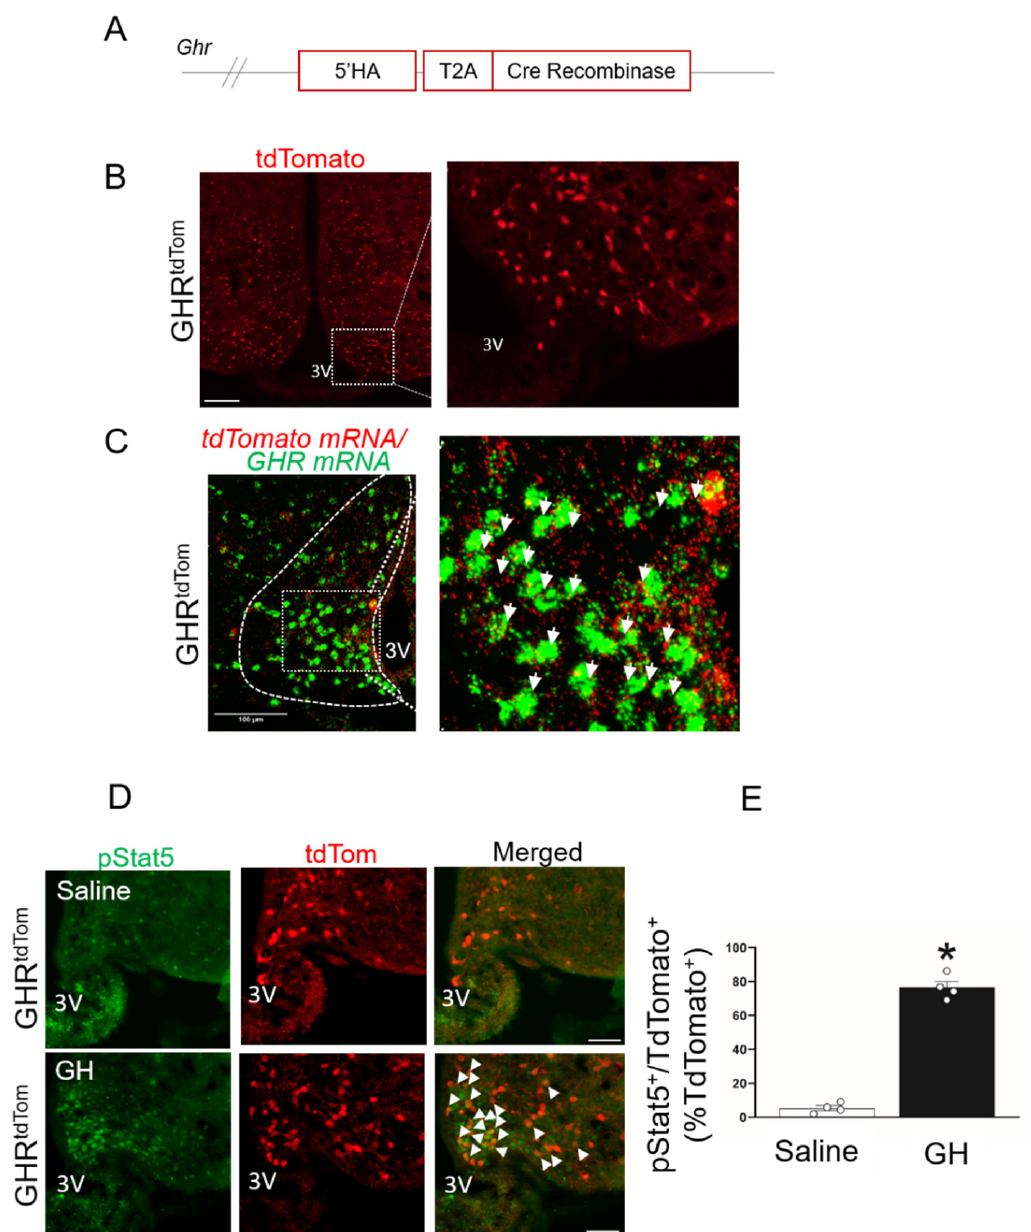
Figure 1. Characterization of growth hormone receptor (GHR)-expressing neurons in the arcuate nucleus of the hypothalamus (ARC). ( A ) Diagram of knock-in insert containing the cre enzyme. T2A—self-cleaving peptide; HA—homology arm. ( B ) Immunofluorescent image of GHR + neurons in the hypothalamus (red, TdTomato ). The dashed box indicates a digitally enlarged region of the ARC. ( C ) Two-plex fluorescent in situ hybridization of GHR mRNA (green) and tdTomato mRNA (red) in the ARC. The dashed box indicates the colocalization of GHR and tdTomato mRNA in the ARC (white arrows). ( D ) Representative images for pSTAT5 in 12-week-old GHR tdTom mice injected i.p. with a vehicle (saline) or GH. pSTAT5 (green), TdTomato (red), and merged images (colocalization is shown by arrows). 3V—third ventricle. Scale bar: 100 µm. ( E ) Quantification of double labeled cells of pSTAT5 and tdTomato to the total % red-labeled cells.* p < 0.05 t -test. See also Figures S1–S3.